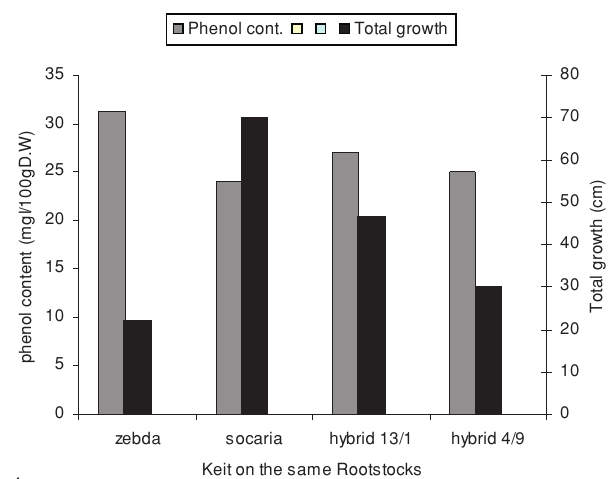
Fig 1 . Relationship between total phenols content (mg/100g dry weight) and total growth of Keit mango as affected by grafting on tested rootstocks in 2006 season.